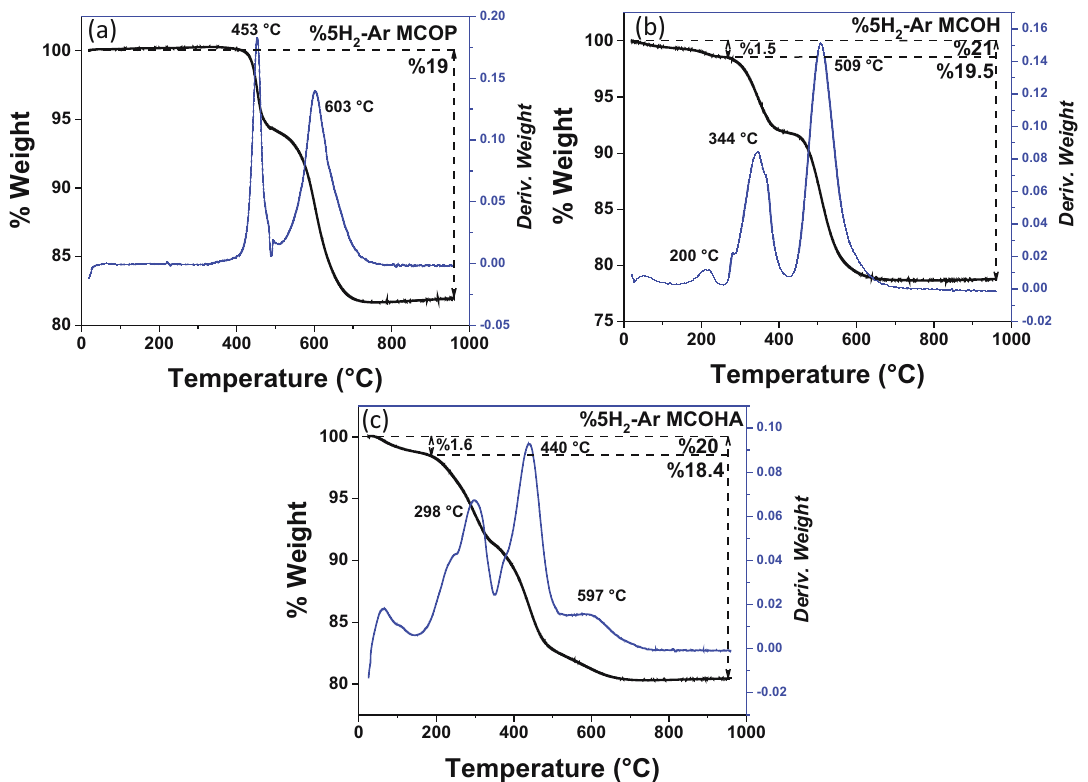
Figure 2: Thermograms of the weight loss of each MCO due to the oxygen released in the reduction with 5% H 2 /Ar. ( a ) MCOP, ( b ) MCOH and ( c ) MCOHA.